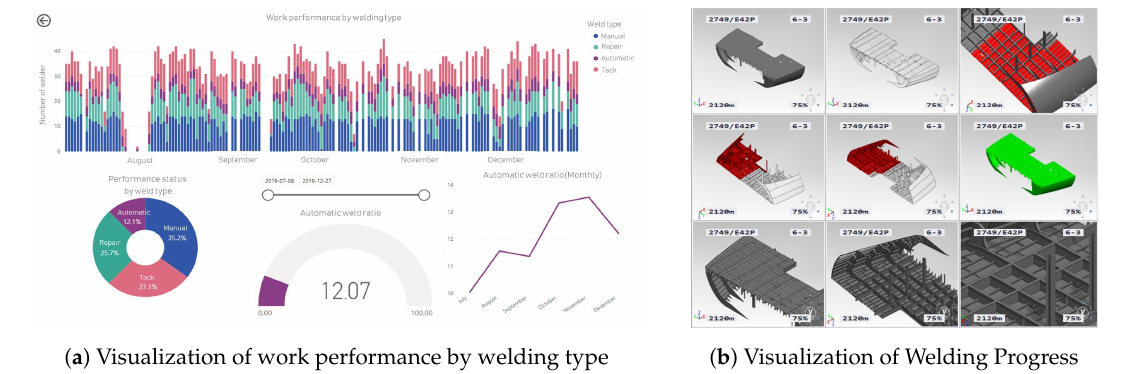
Figure 17. Measurement and visualization of welding activity